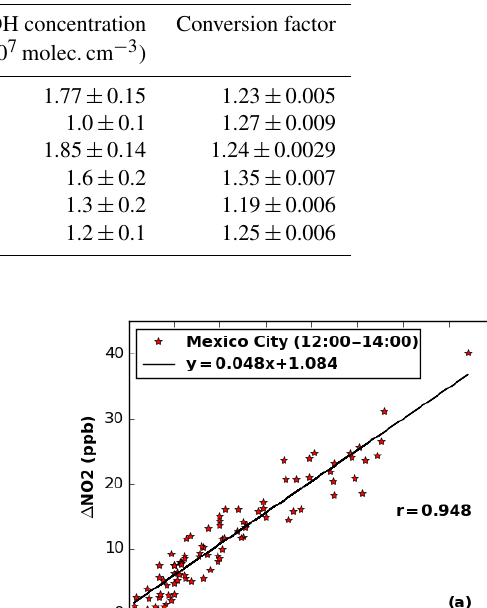
Table 2. Average wind speed and boundary layer CAMS OH concentration for June–August 2018 that was used to correct for the limited lifetime of NO 2 . The errors presented represent the 1 σ uncertainty calculated by the bootstrapping method.